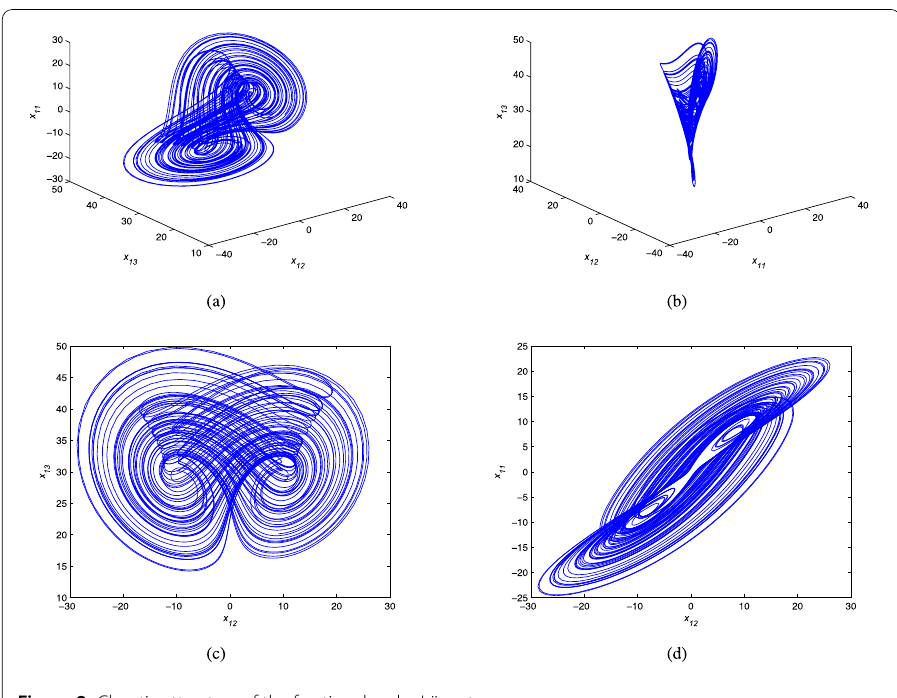
Figure 2 Chaotic attractors of the fractional-order Lü system